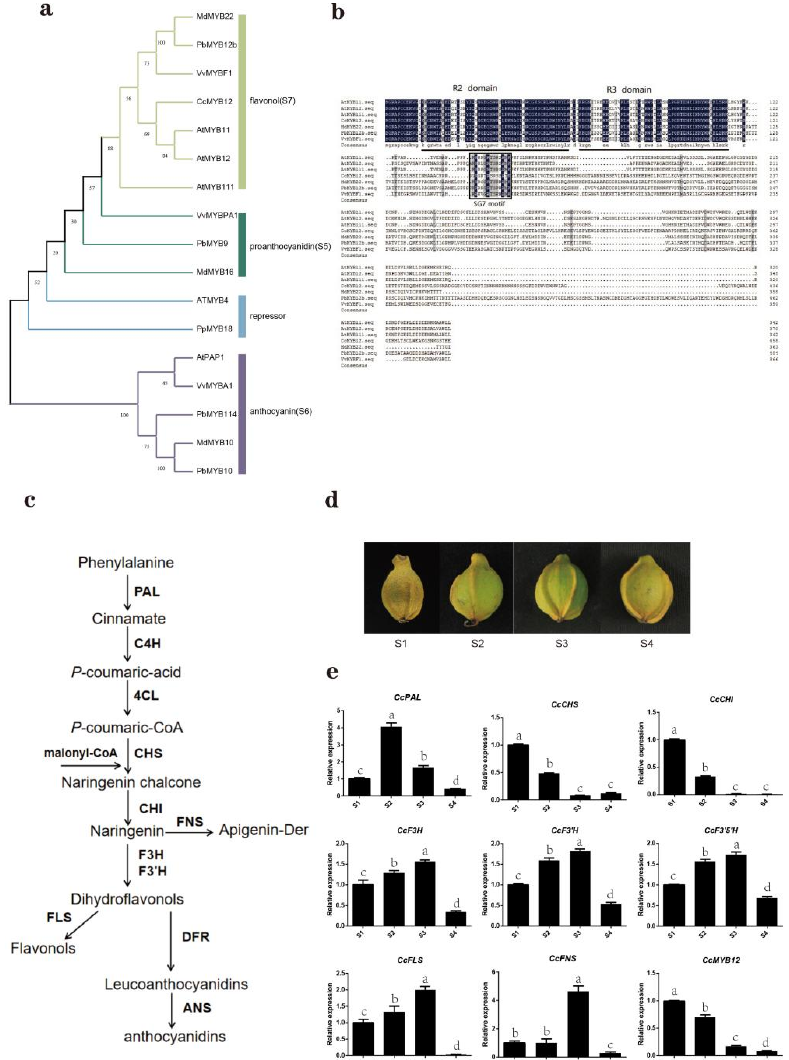
Figure 4. Relationship between CcMYB12 and flavonol accumulation in Carya cathayensis . ( a ) Phy- logenetic analysis of CcMYB12 and R2R3 transcription factors regulating flavonoids, generated by NJ method in MEGA 7.0. ( b ) Protein sequence alignment of CcMYB12 and R2R3-MYB transcription factors from Subgroup 7. Positions of R2 and R3 MYB domains are indicated by black bar below alignment. SG7 domain is highlighted by a black box. ( c ) Plotted diagram of flavonoid synthesis pathway based on KEGG data. ( d ) Developing fruits of Carya cathayensis . Sampling time points noted as S1, S2, S3, and S4. ( e ) Relative expression levels of flavonoid-synthesis-related genes and CcMYB12 in hickory exocarp at indicated time points. Different letters in the error bar indicate ob- vious differences among samples, as determined by ANOVA (Duncan test, p < 0.05).